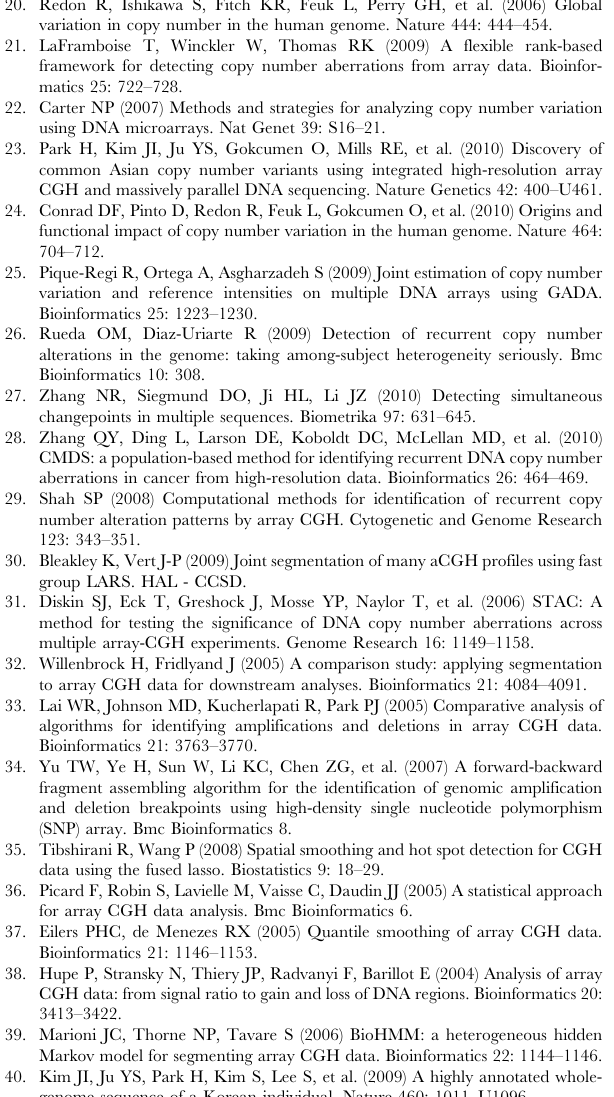
Figure S4 F1 score of 5 comparing algorithms and MGVD on chromosome